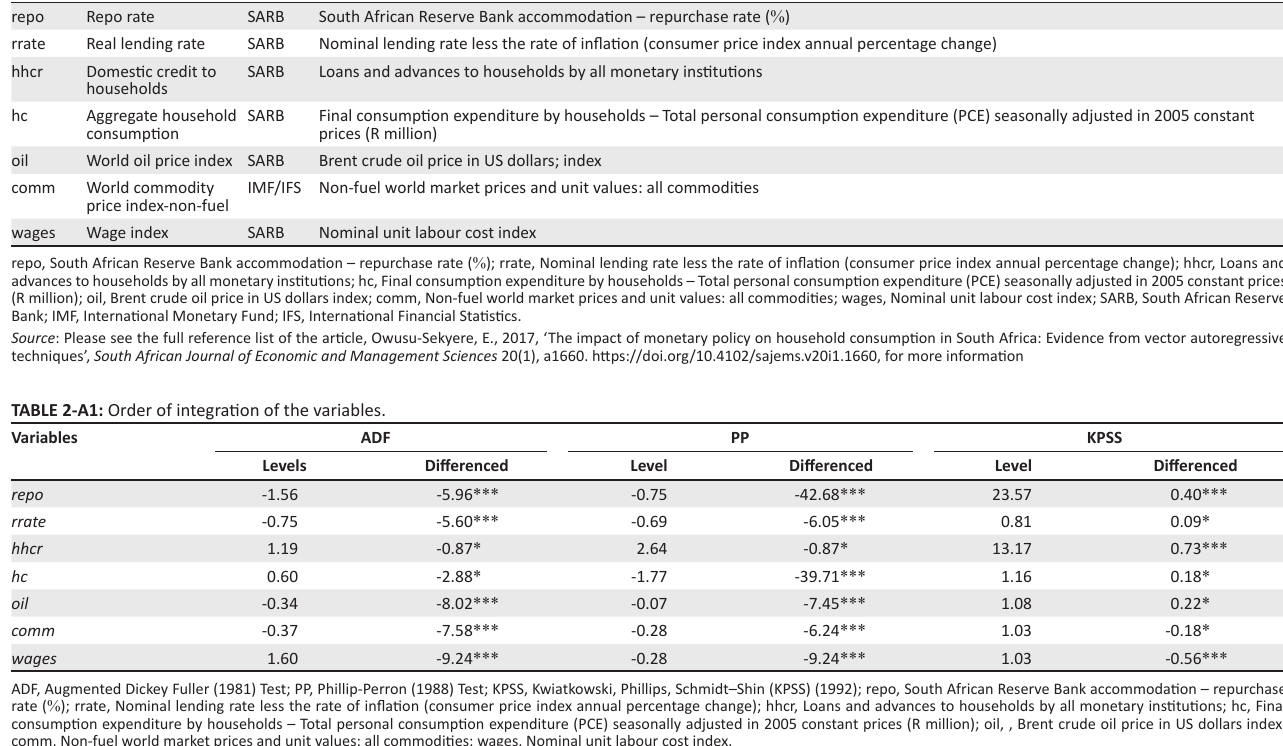
TABLE 1-A1: Sources and definitions of variables. Symbol Variable